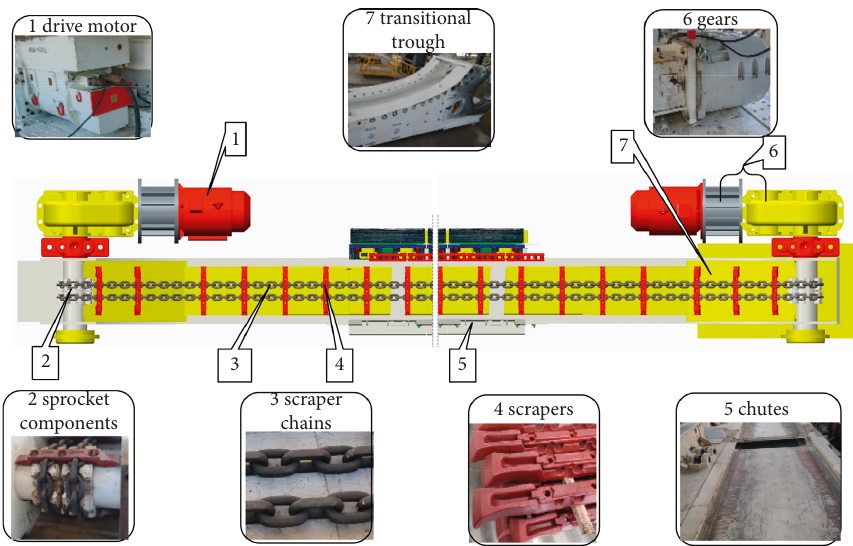
Figure 1: Transmission system of the scraper